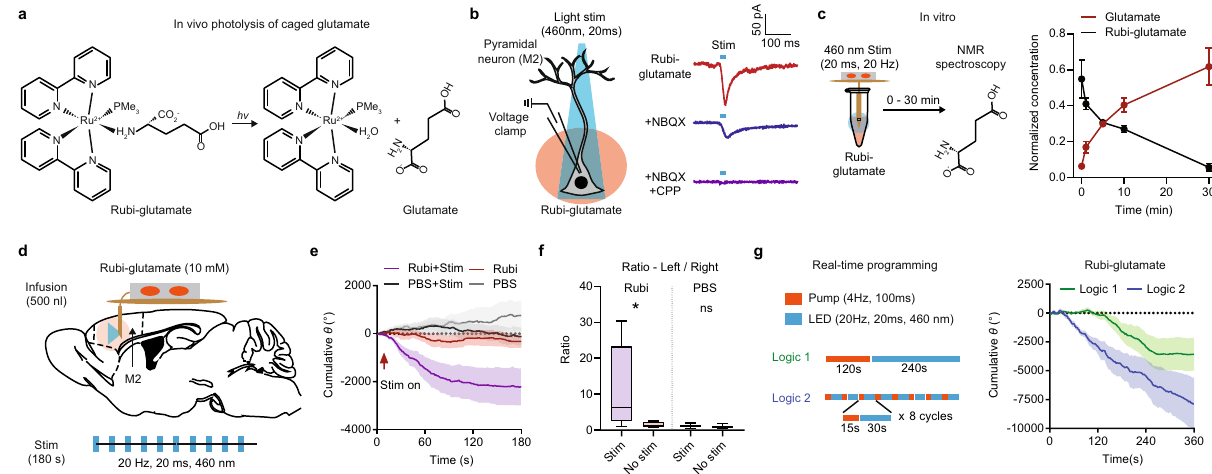
Fig. 5 | Optopharmacological control of motor behavior using multilateral opto fl uidics device. a Chemical formula showing the photolysis of Rubi- glutamate. b Left, schematic showing voltage clamp recording of a pyramidal neuron in M2 upon photolysis of Rubi-glutamate using 460nm light stimulation. Right, example of EPSCs evoked by photolysis of Rubi-glutamate (50 µ M) Holding potential, − 70mV. NBQX and CPP, 10 µ M. Light stimulation, 460nm, 20ms pulse width. c Left, schematic showing in vitro photolysis of Rubi-glutamate using opto fl uidic devices. Concentration of Rubi-glutamate and glutamate were mea- sured by Nuclear magnetic resonance (NMR) spectroscopy following light stimu- lation(0 – 30min,460nm,20mspulsewidth,20Hzfrequency).Right,normalized concentration of Rubi-glutamate and glutamate after different duration of pho- tolysis. n =3 independent experiments. d Schematic showing the experimental design of optopharmacology using Rubi-glutamate in vivo. e Summary data